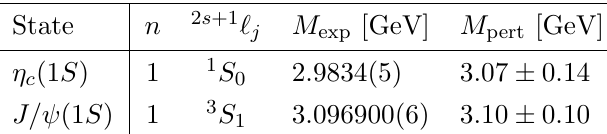
Table 5. Masses of the charmonium states with n = 1, calculated with the perturbative formula of eq. (2.1). The results are computed with the (cid:12)nal charm quark (cid:12)t value of m c = 1 : 273